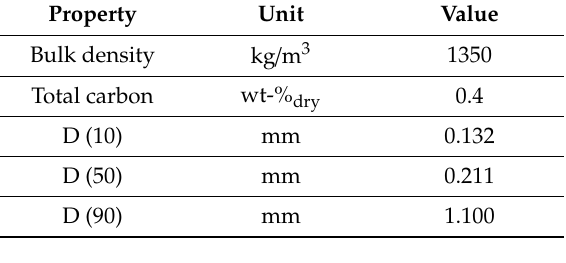
Table A2. Bottom ash analysis.